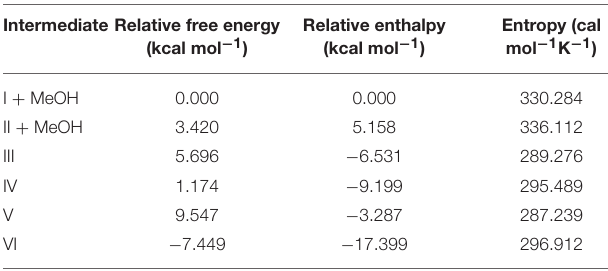
TABLE 3 | Thermochemical data of intermediates derived from DFT calculations a